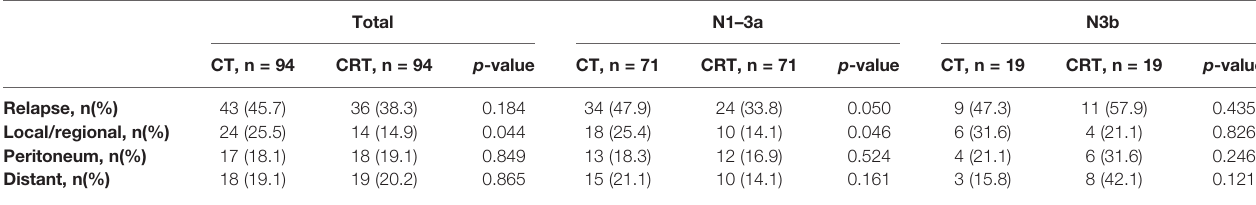
TABLE 4 | Patterns of failure in CRT and CT